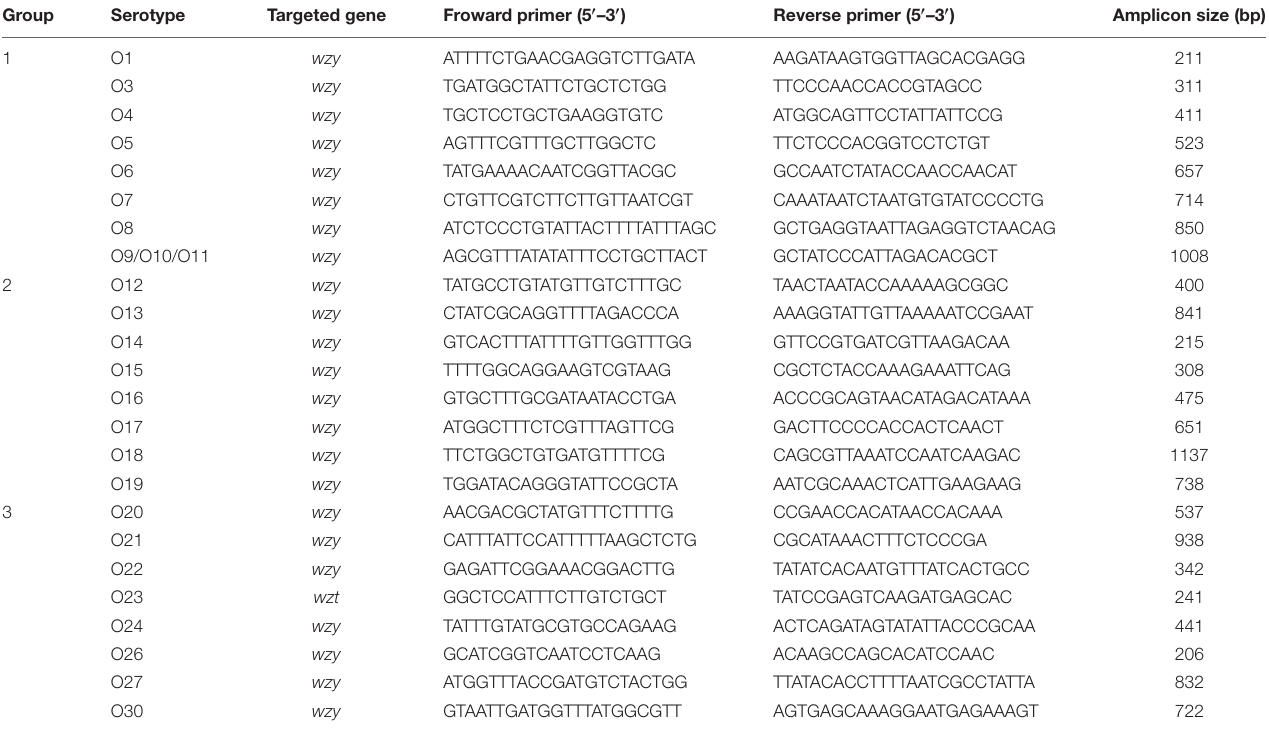
TABLE 2 | Primers used in this